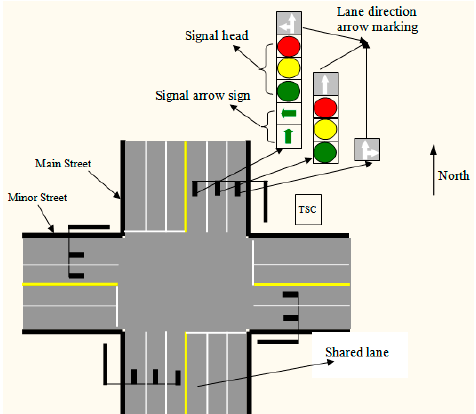
Figure 2. The new intersection signal control model diagram.